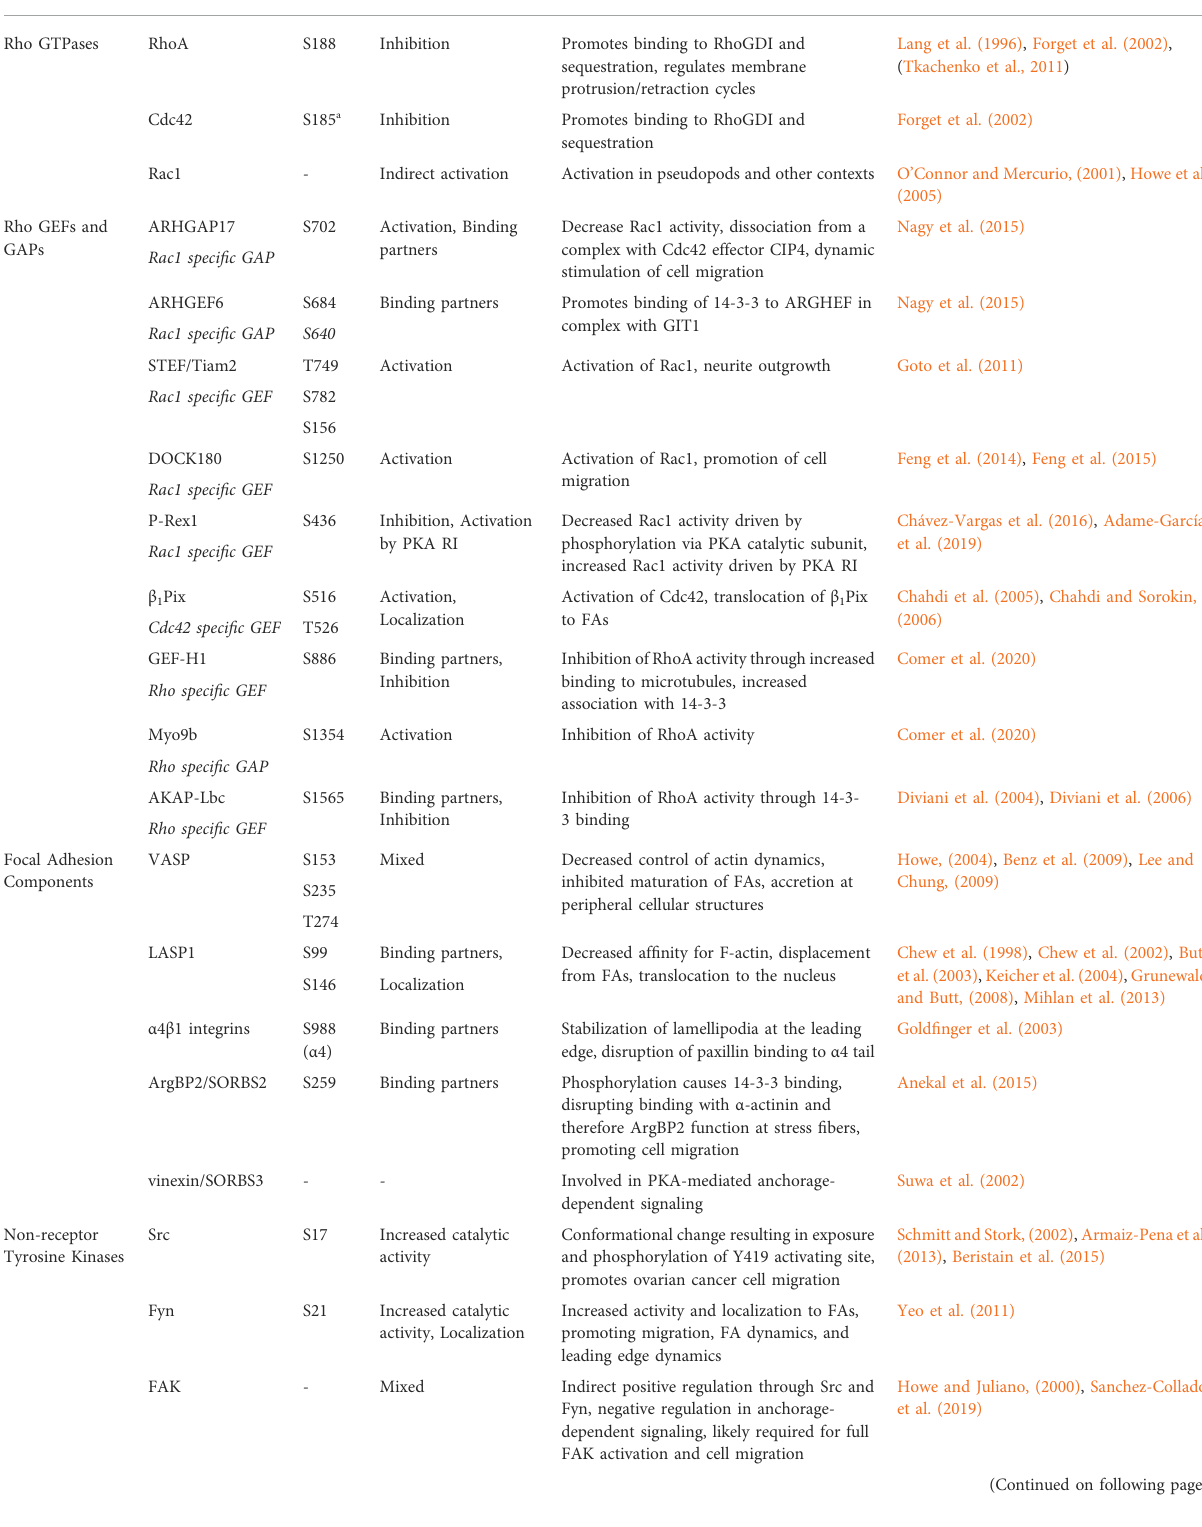
TABLE 1 Migration-related targets of PKA